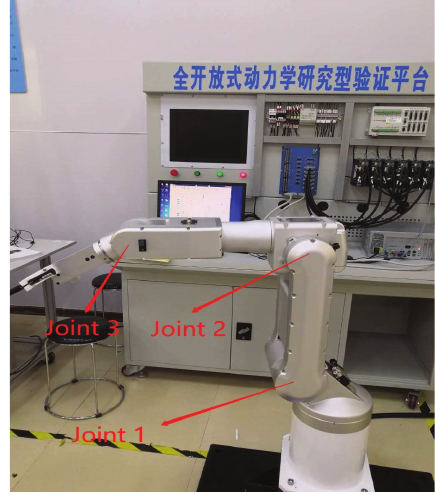
Figure 1. Robot experiment